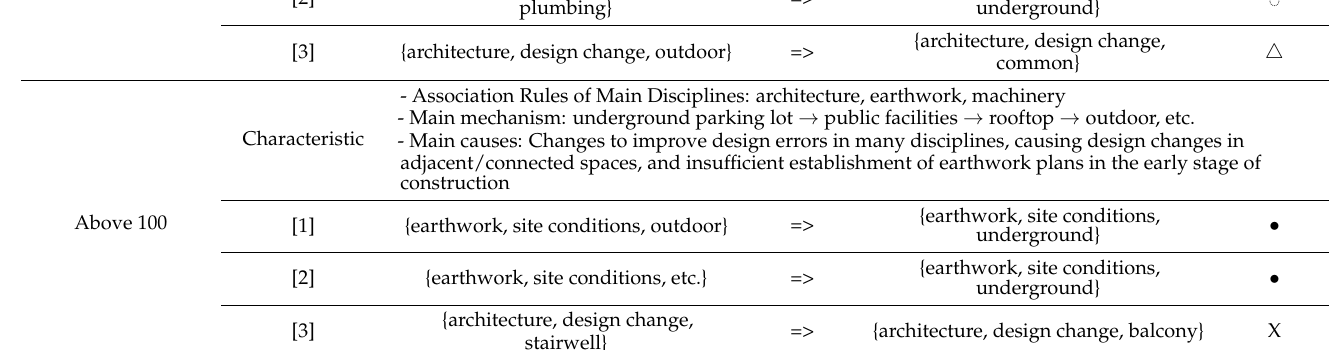
Table 3. Association rule classification system through expert interview.